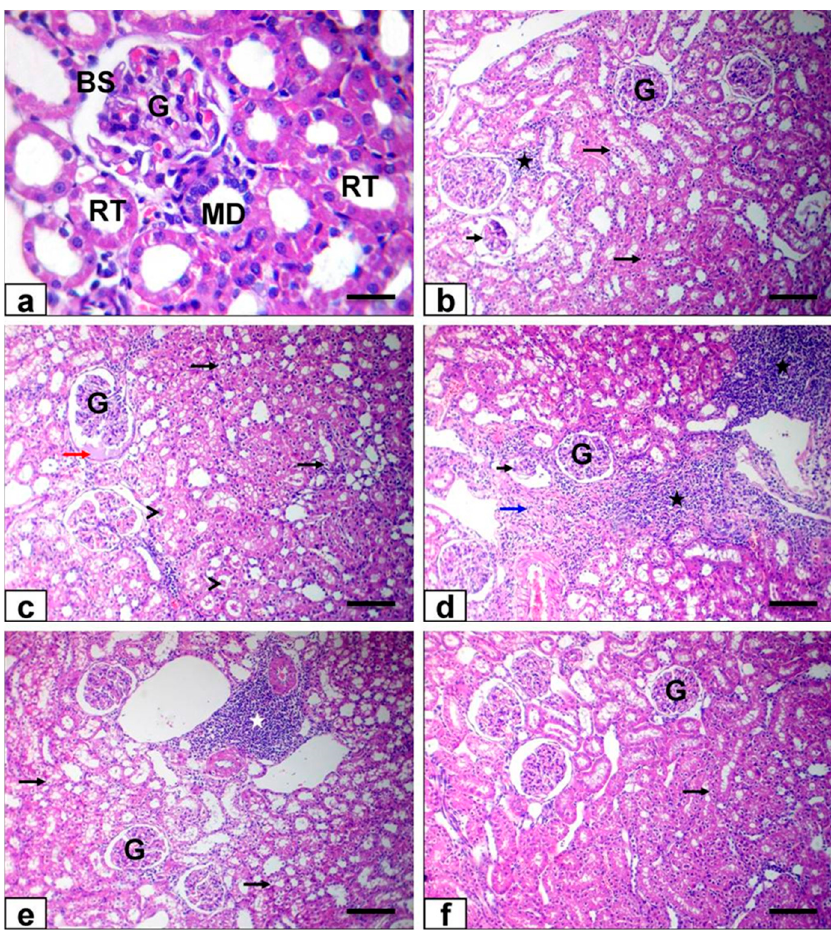
Figure 7. Photomicrograph of kidney sections stained with HE: ( a ) kidney of control group showing normal histoarchitecture ( b – e ) kidney of malathion-treated rats showing hydropic vacuolation of the epithelium of renal tubules (long black arrows) and intraluminal hyaline casts (arrowheads), dilatation of Bowman’s space by eosinophilic glomerular filtrate (red arrow), atrophy and necrotic glomerulus (short black arrows), as well as interstitial mononuclear cell infiltrations (white and black stars) and mild fibroplasia (blue arrow) ( f ) Ornipural ® with malathion -treated rats showing nearly normal histological structure with mild hydropic epithelial cell degenerations (long black arrows). (Bar of all figures 100 µm, except a 50 µm). G, glomeruli, RT, renal tubules, BS, Bowman’s space, MD, macula densa.